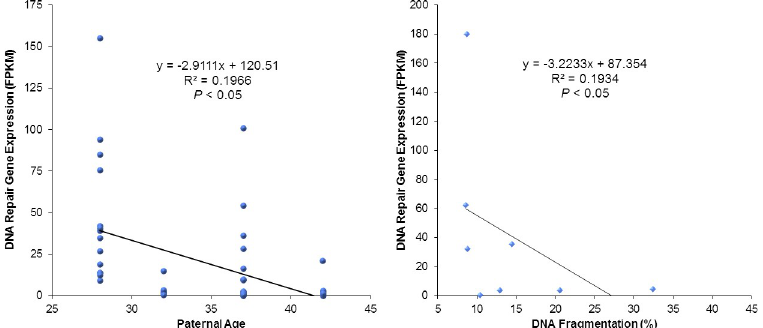
Fig 11. Effect of paternal age and DNA fragmentation on DNA repair gene expression. Assessment of the 7 most significant differentially expressed genes according to paternal age (left graph) showed an inverse correlation, with the oldest men having much lower expression of these DNA repair and apoptotic regulating genes ( P < 0.05). Similarly, plotting the expression of these genes in function of increasing sperm DNA fragmentation (right graph) illustrated that the higher the expression of genes related to DNA repair and apoptosis, the lower the sperm DNA fragmentation ( P < 0.05).